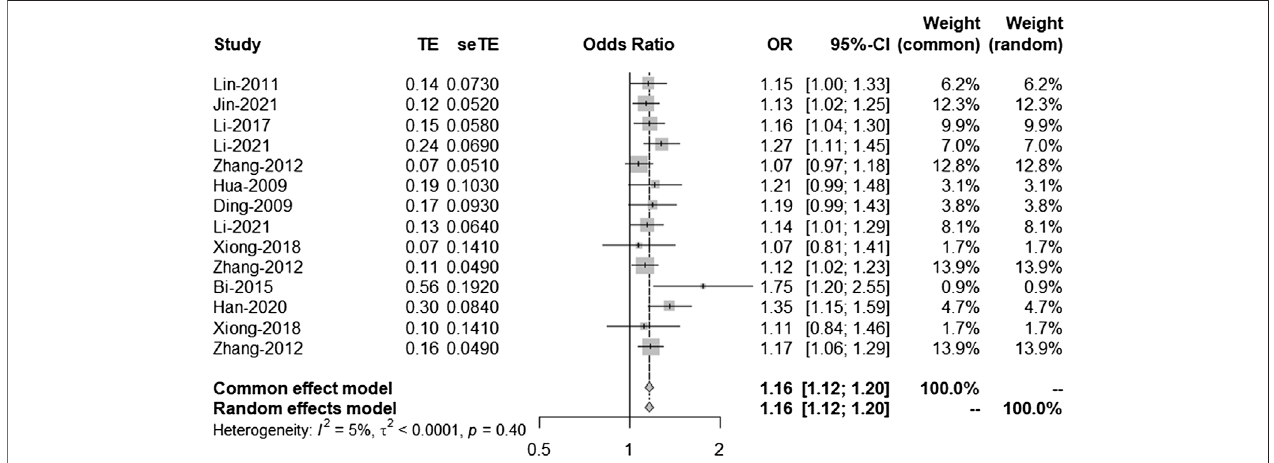
FIGURE 5 | Funnel plots corresponding to the fi xed-effects meta-analysis of the three single-nucleotide polymorphisms (SNPs; rs2383207, rs2383206, and rs10757278) and ischemic stroke (IS) in the second analysis.